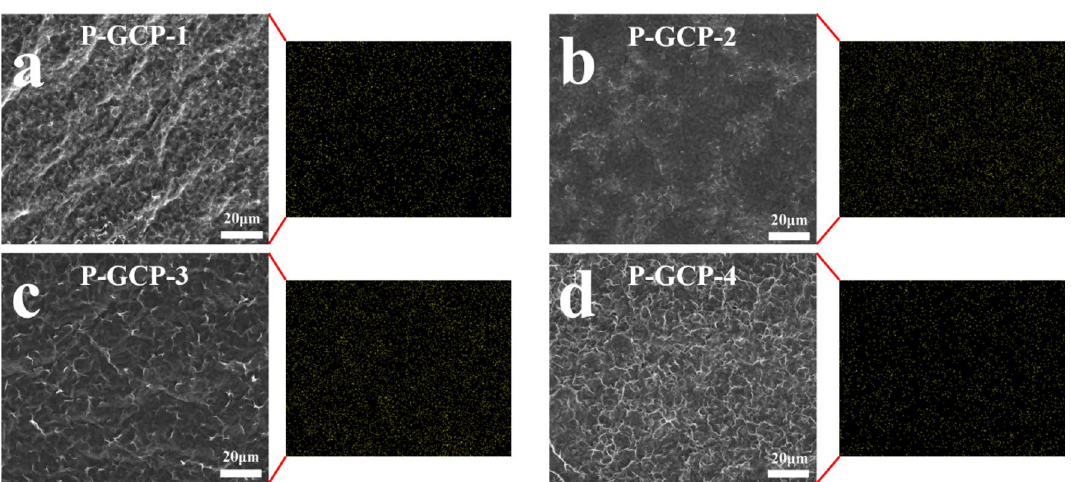
Figure 3. Corresponding EDS of Cu element originating from CuCl 2 in P-GCP, revealing that copper nanoparticles are homogeneously distributed without